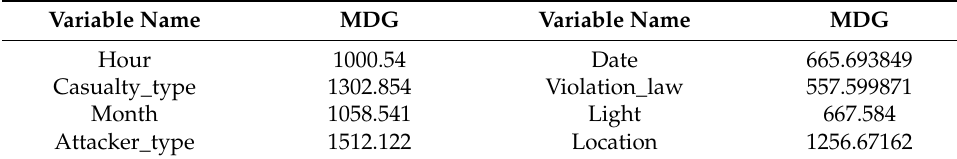
Table 2. The final result of the variable importance using the MDG coefficient.